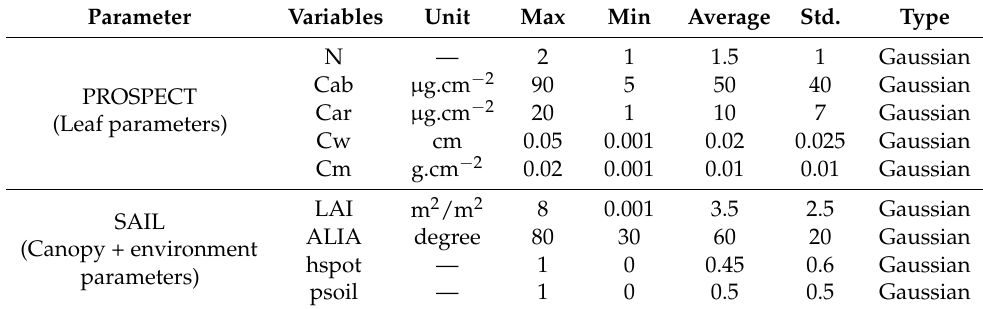
Table 2. Ranges and distributions of PROSAIL input parameters for the simulated datasets generation.